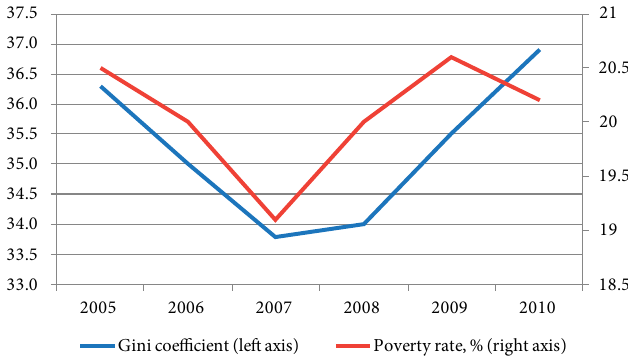
Fig. 1. Changes of Gini coefficient and poverty rate in Lithuania in 2005–2010 (Source: Statistics of Lithuania and authorial